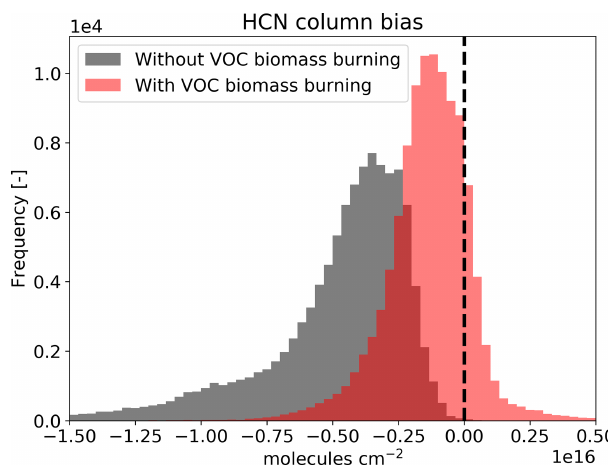
Figure 5. Global HCN column bias between EMAC simulations and IASI satellite data. The column bias is calculated based on monthly mean data during the Indonesian peatland fires in 2015.